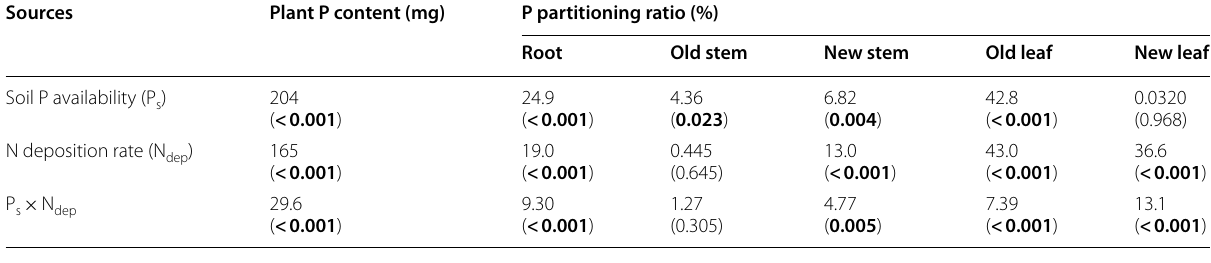
), N deposition rate (N s 4) indicated by F and ( P ) values derived from ANOVA analyses. Statistically significant effects =